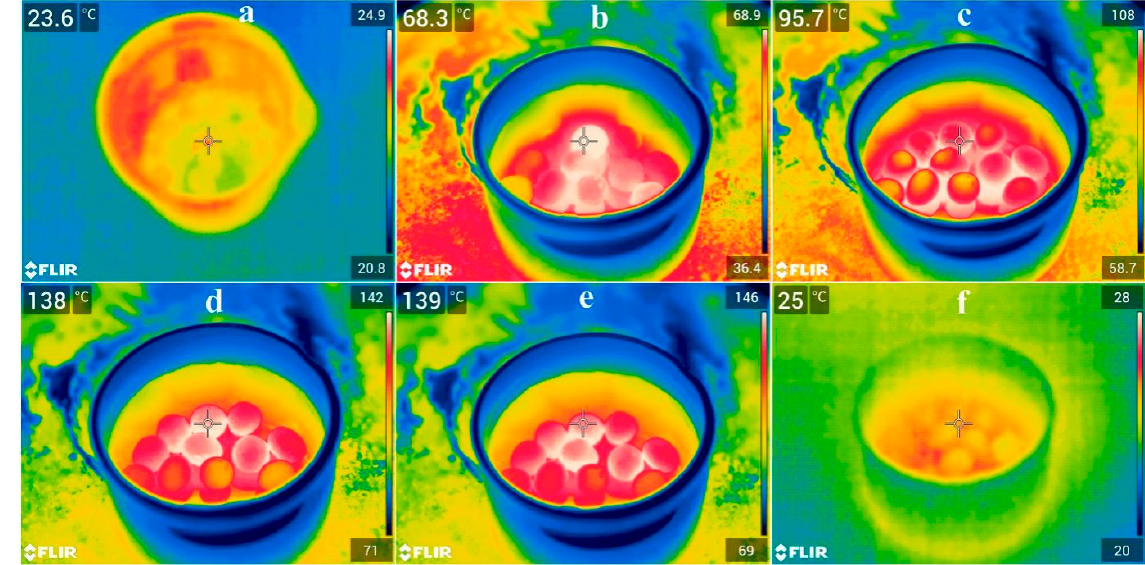
Figure 6. Photo-to-thermal conversion performance of H + /BCQDs/UiO-66-NH 2 @ceramsite after different IR light irradiations. ( a ) 0 h; ( b ) 1 h; ( c ) 2 h; ( d ) 3 h; ( e ) 4 h; ( f ) light off and stand for 15 min.